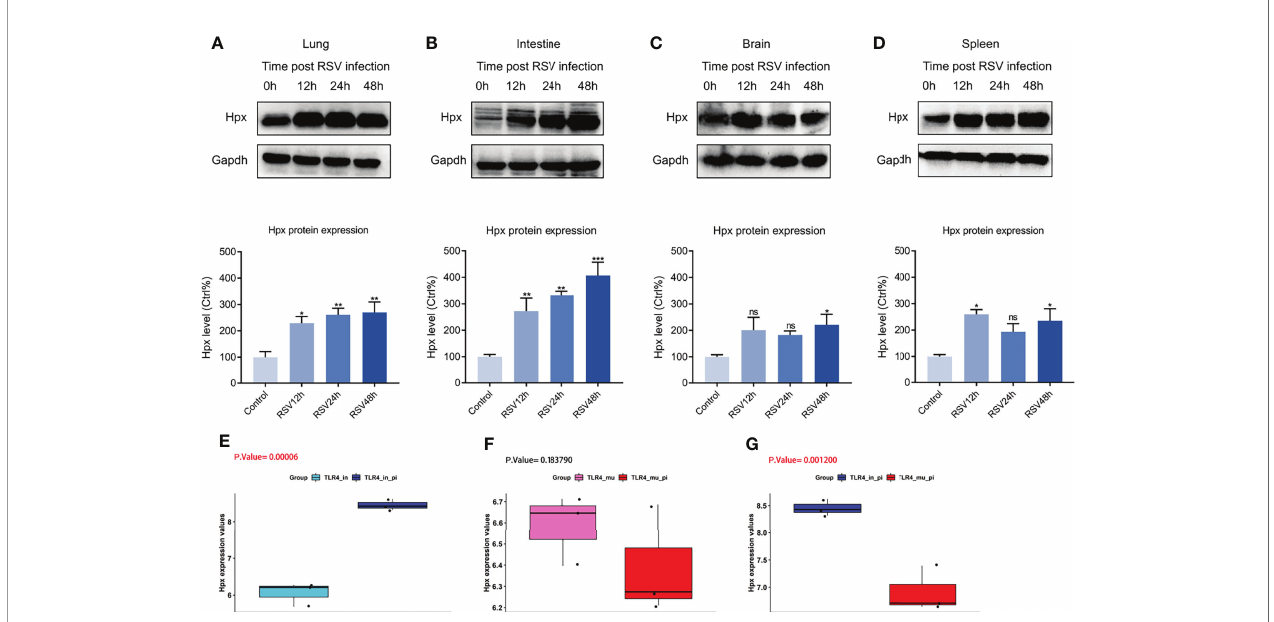
FIGURE 5 | Western blotting and GEO database validation of Hpx expression in four organs post-RSV infection. (A – D) Western blotting of Hpx protein levels in RSV-infected BALB/c mice at different time points in lung, intestine, brain, and spleen. p < 0.05. * p < 0.05, ** p < 0.01, *** p < 0.001, compared with control group. Hpx expression in (E) TLR4-intact and TLR4-intact infected mice, (F) TLR4 mutant and TLR4 mutant infected mice, (G) TLR4 intact infected and TLR4 mutant infected mice based on GEO database. ns.